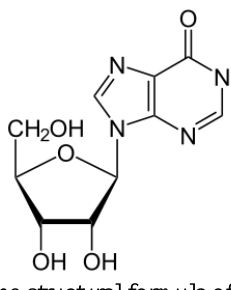
Fig. 1. The structural formula of riboxinum